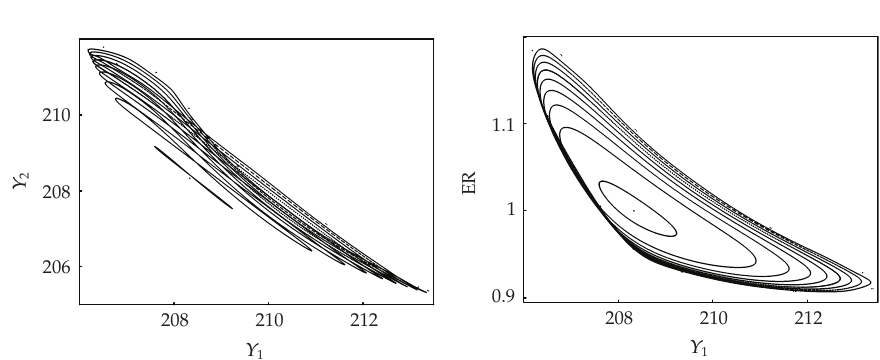
Figure 5: Interregional cycles occurring for δ (cid:9) 0 . 6 and β (cid:9) 300 and α from 0.627 to 0.629, shown in their (cid:7) and (cid:4) Y (cid:7) (cid:4) Y 1 ,Y 2 1 , ER